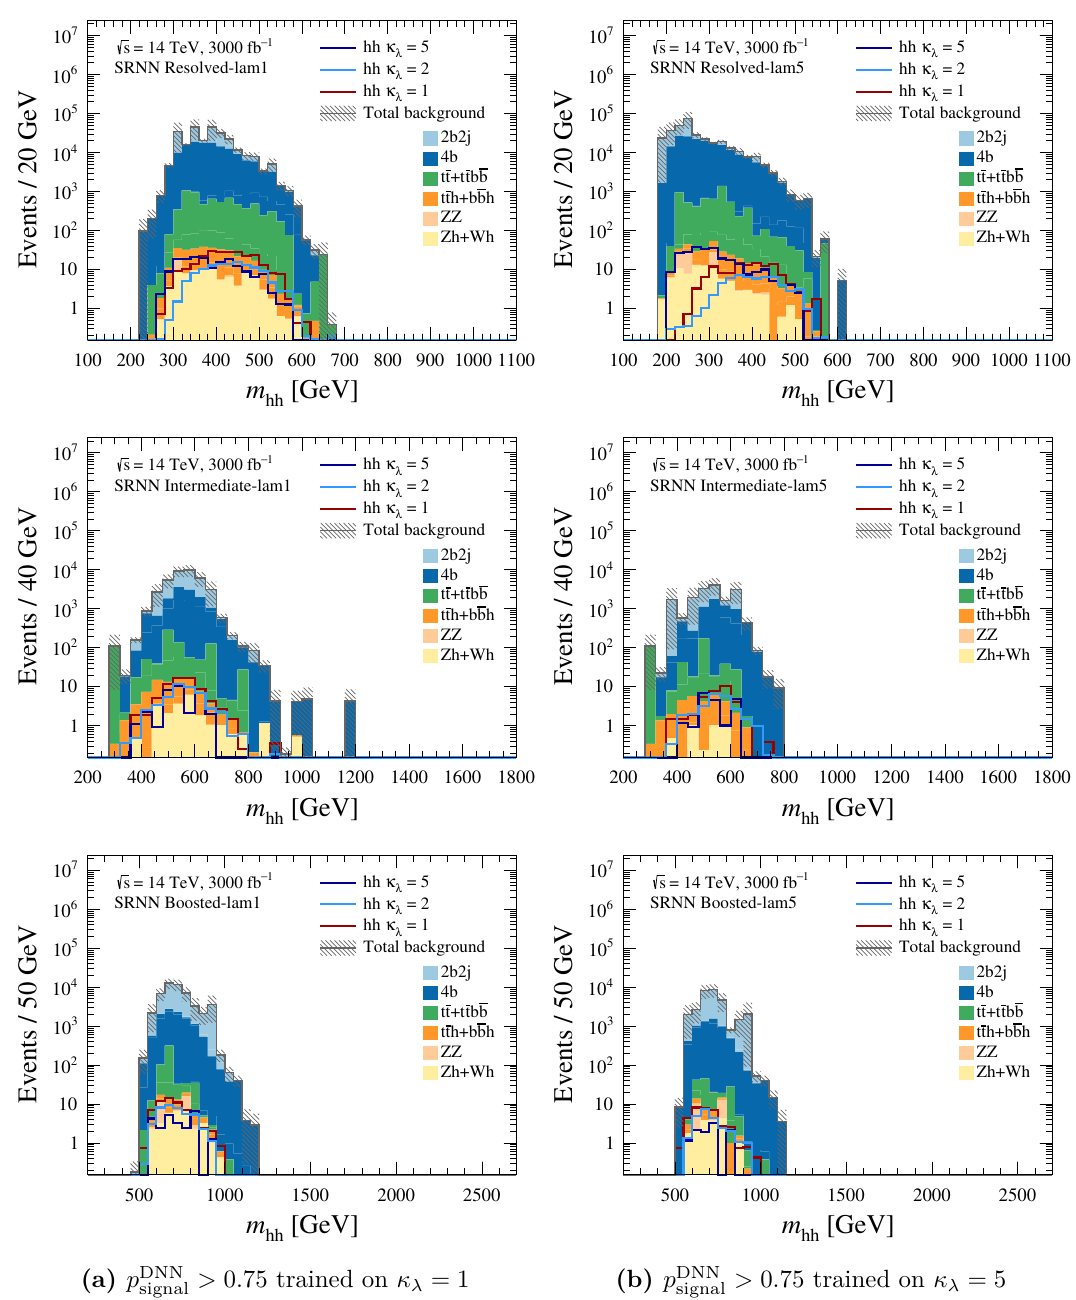
Figure 9. The m hh distributions of benchmark signals (solid lines) and background processes (filled stacked) displayed in the legend. All event selection criteria of the neural network analysis are imposed. The DNN is trained on (a) κ λ = 1 and (b) κ λ = 5 signals. These are displayed for (upper) resolved, (middle) intermediate and (lower) boosted categories. The plots are normalised to L = 3000 fb − 1